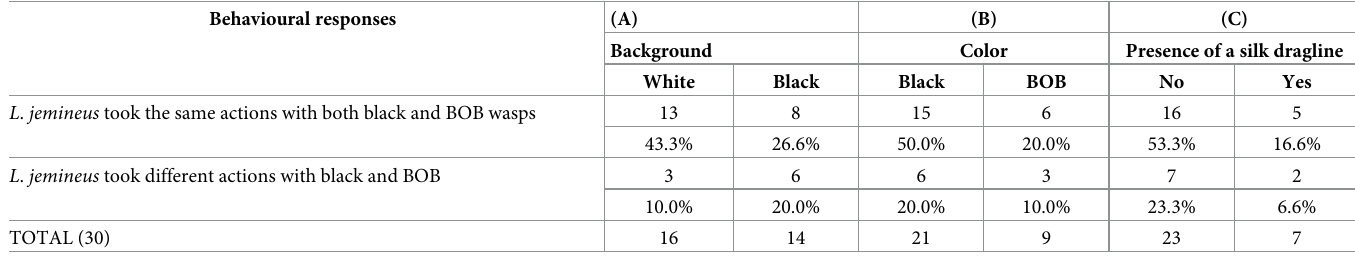
Table 2. Results from experiment with false prey in three contingency